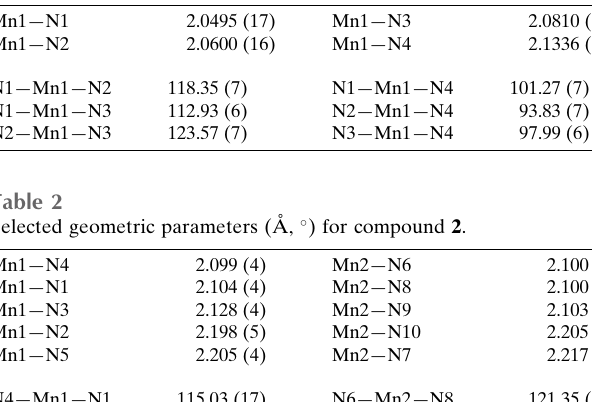
Figure 5 Crystal structure of compound 1 in a view along the a axis. Intermolecular hydrogen bonding is shown as dashed lines.